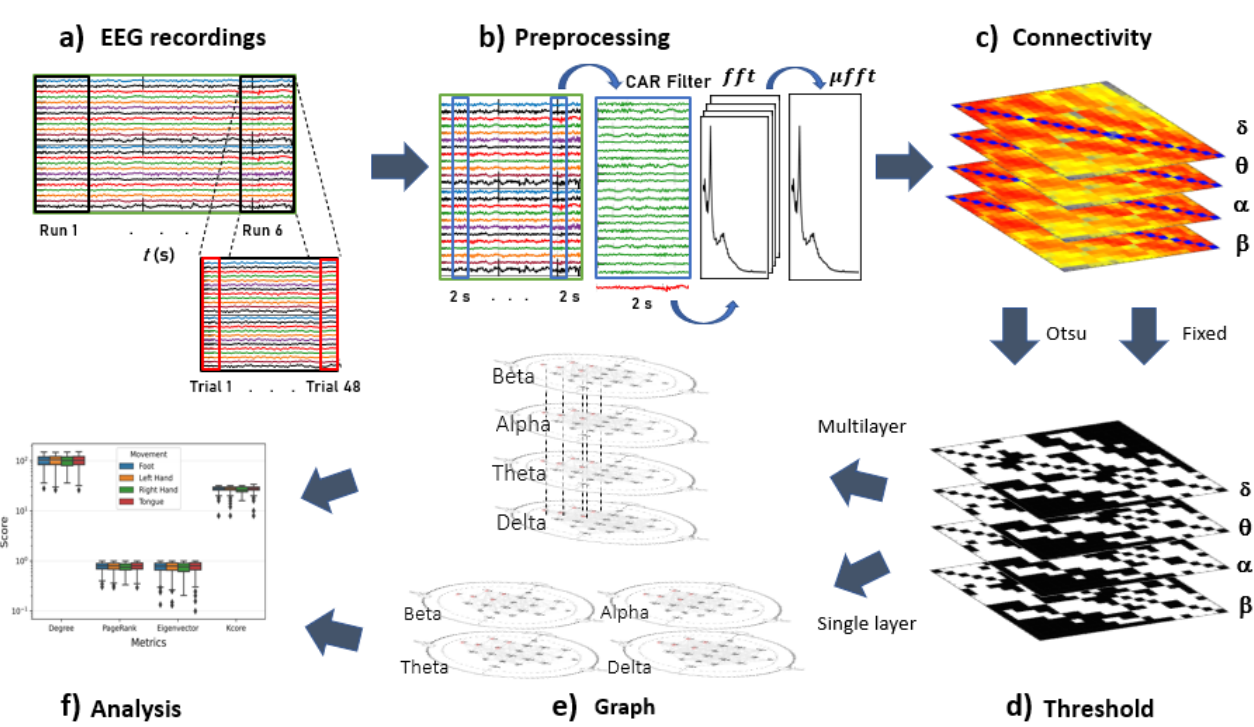
Figure 2. Schematic flowchart of the study methodology. Here, ( a ) correspond to the acquisition paradigm of all four classes of motor imagery, ( b ) data prepossessing, while ( c – f ) outline the stages of the connectivity graph